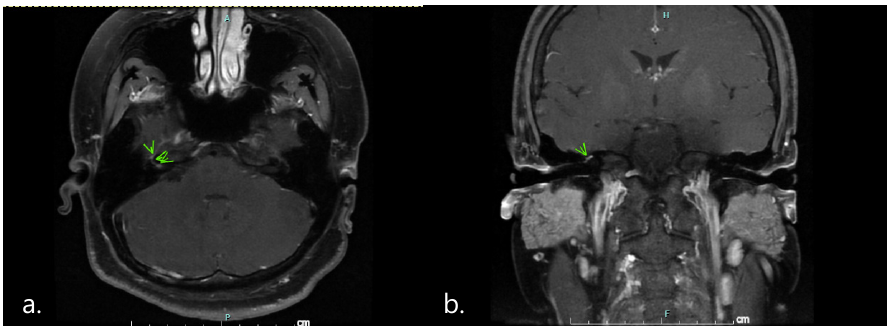
b. b. a. b. Figure 4. Post-gadolinium T1-weighted ( a ) an axial view; ( b ) a coronal view imaging of magnetic Figure 4. Post-gadolinium T1-weighted ( a ) an axial view; ( b ) a coronal view imaging of magnetic Figure 4. Post-gadolinium T1-weighted ( a ) an axial view; ( b ) a coronal view imaging of magnetic Figure 4. Post-gadolinium T1-weighted ( a ) an axial view; ( b ) a coronal view imaging of magnetic resonance images revealed abnormal enhancement of right cranial nerve VII at the canalicular and resonance images revealed abnormal enhancement of right cranial nerve VII at the canalicular and resonance images revealed abnormal enhancement of right cranial nerve VII at the canalicular and resonance images revealed abnormal enhancement of right cranial nerve VII at the canalicular and labyrinthine segments and the genu (arrowheads). These findings are compatible with neuritis. labyrinthine segments and the genu (arrowheads). These findings are compatible with neuritis. labyrinthine segments and the genu (arrowheads). These findings are compatible with labyrinthine segments and the genu (arrowheads). These findings are compatible with neuritis.